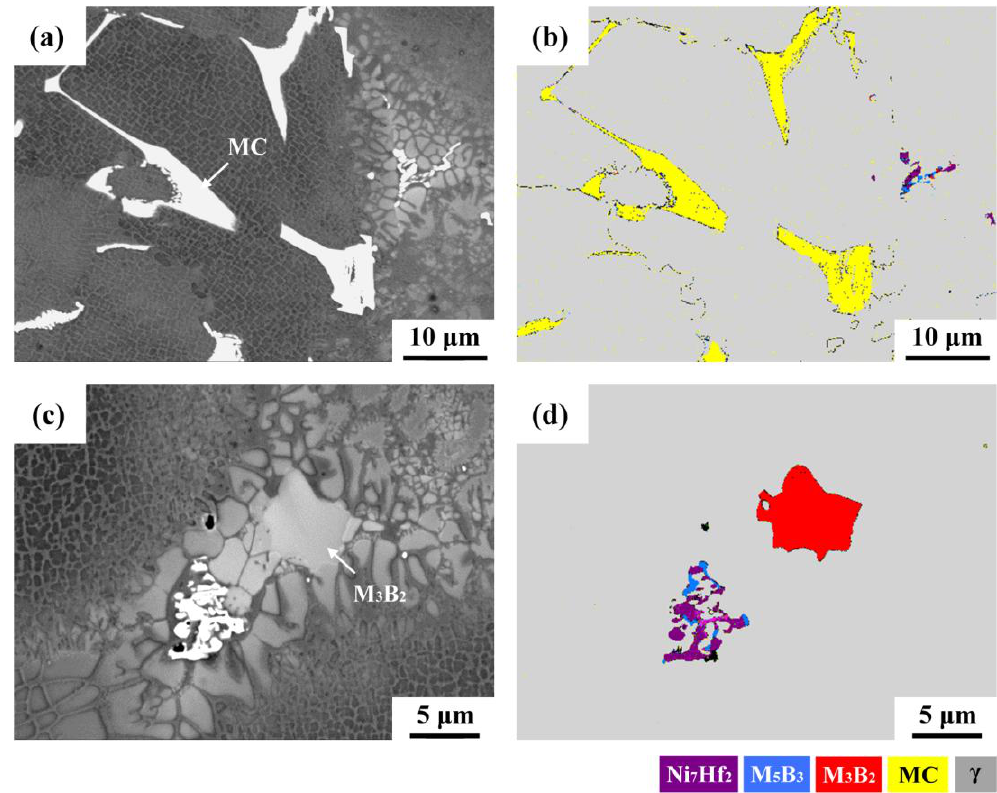
Figure 4. The analysis of solidification products in the cast superalloy: ( a ) back-scatter electron (BSE) image of MC carbides and their associated ( b ) electron backscatter diffraction (EBSD) map; ( c ) BSE image showing the boundary microconstituents and related ( d ) EBSD map showing the presence of borides and lamellar intermetallics.